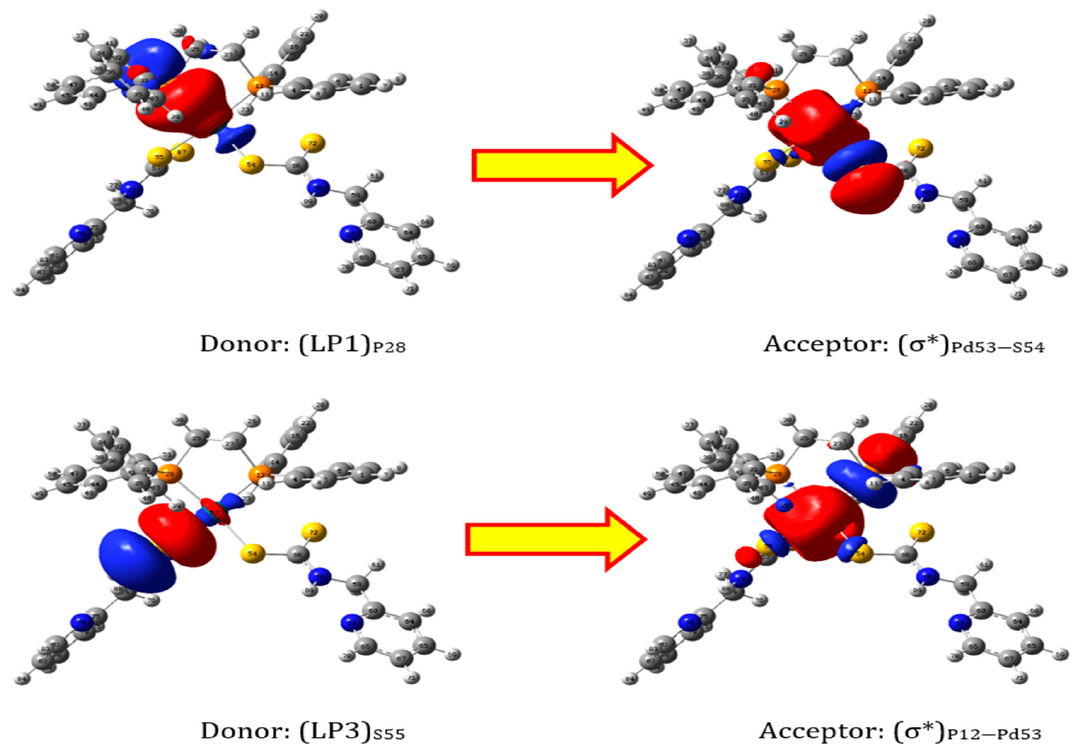
Figure 5. Donor and acceptor orbitals of two highest second order perturbation energies of Pd(1) complex.